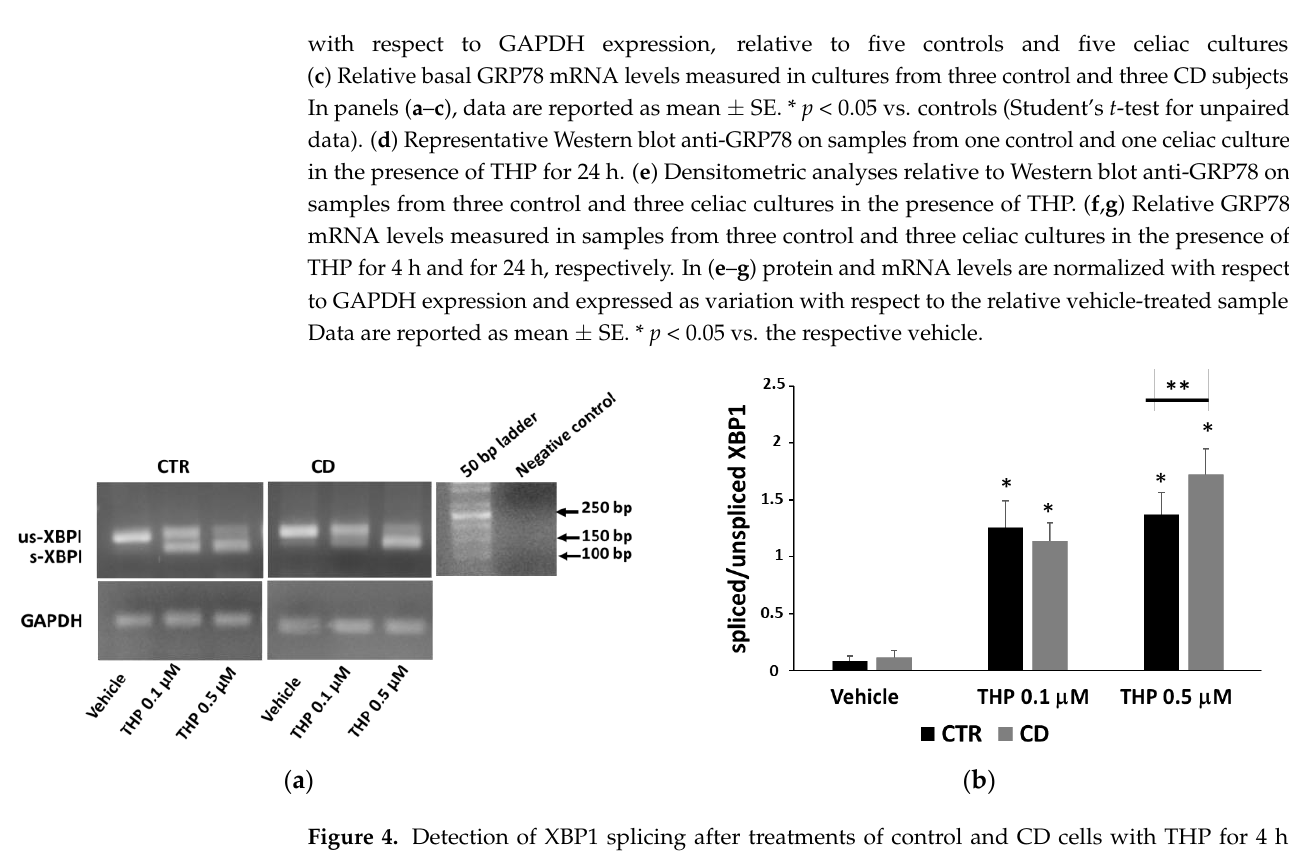
Figure 4. Detection of XBP1 splicing after treatments of control and CD cells with THP for 4 h. ( a ) Spliced (s) and unspliced (us) forms of XBP1 in representative samples are detected in a 2.5% agarose gel after staining with ethidium bromide. ( b ) Quantification of XBP1 splicing in cultures from three control and three CD subjects expressed as a ratio between densitometric values of s-XBP1 and us-XBP1. Data are reported as mean ± SE. * p < 0.05 vs. the respective vehicle. ** p < 0.05 as indicated (Student’s t- test for unpaired data).